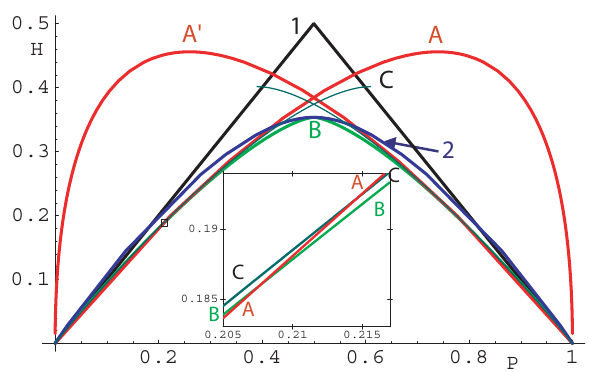
Figure 4. Noise entropy Halong various decision boundaries with exponential inputs: ‘‘stretched circles’’ with spiking outside A or inside A 9 , extended solutions B and C; straight lines parallel to coordinate axes (1) and at 6 p /4 angle (2). Solutions (A-C) and (1) satisfy the optimality Eq. (9), but not (2), which is optimal only at a single point at p =1/2 where it becomes part of family of extended solutions B. Inset shows that switching occurs between solutions A and B.